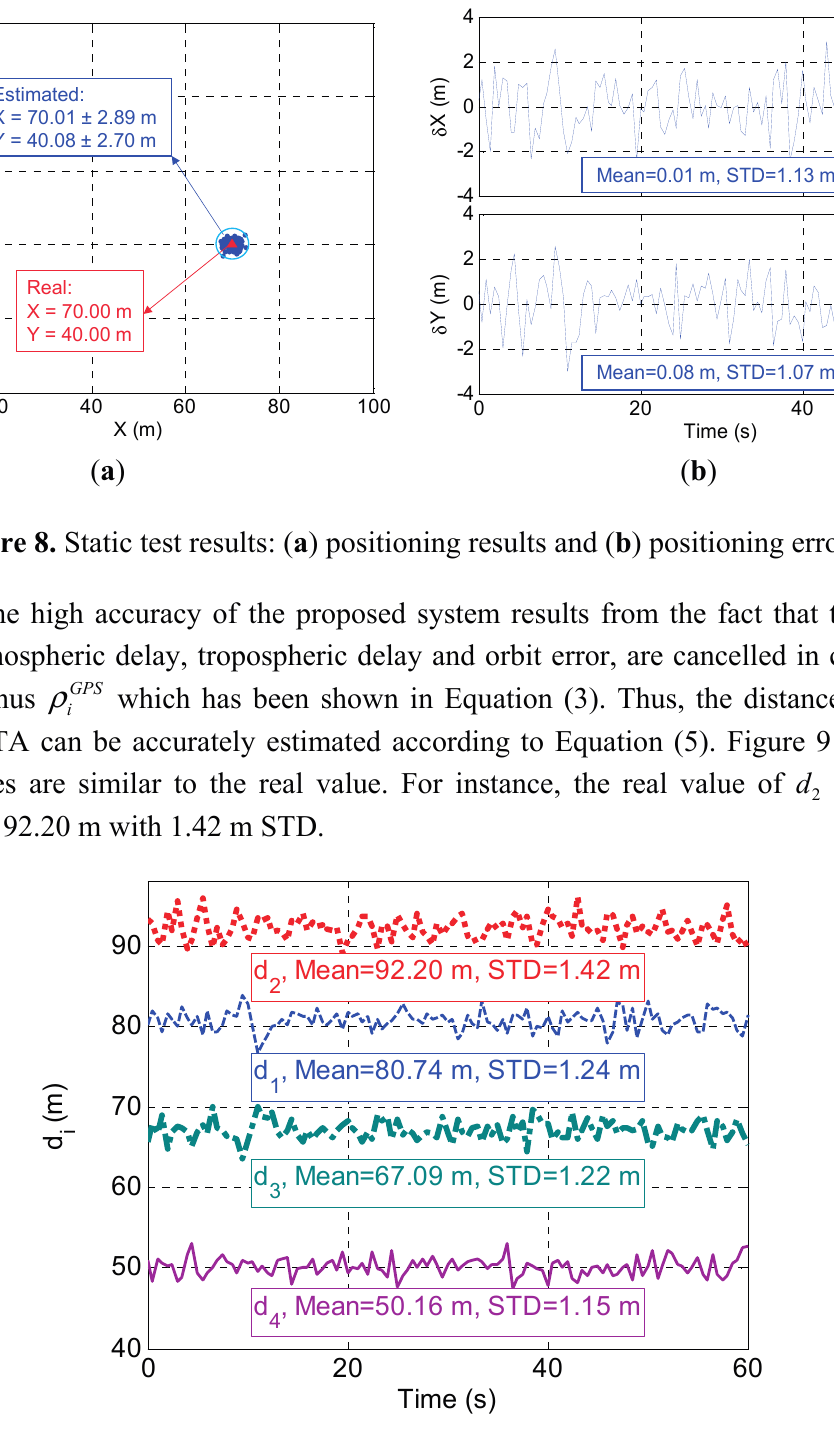
Figure 9. Estimated distance between the user terminal and each